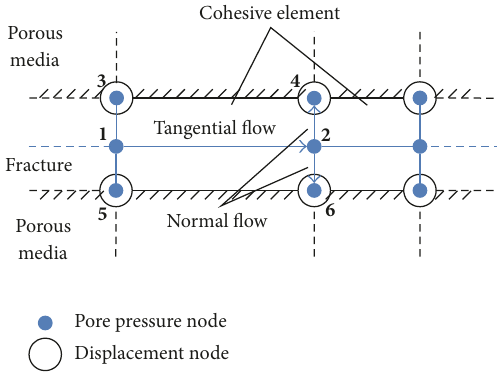
Figure 1: Fluid flow within the PPCE in 2D.